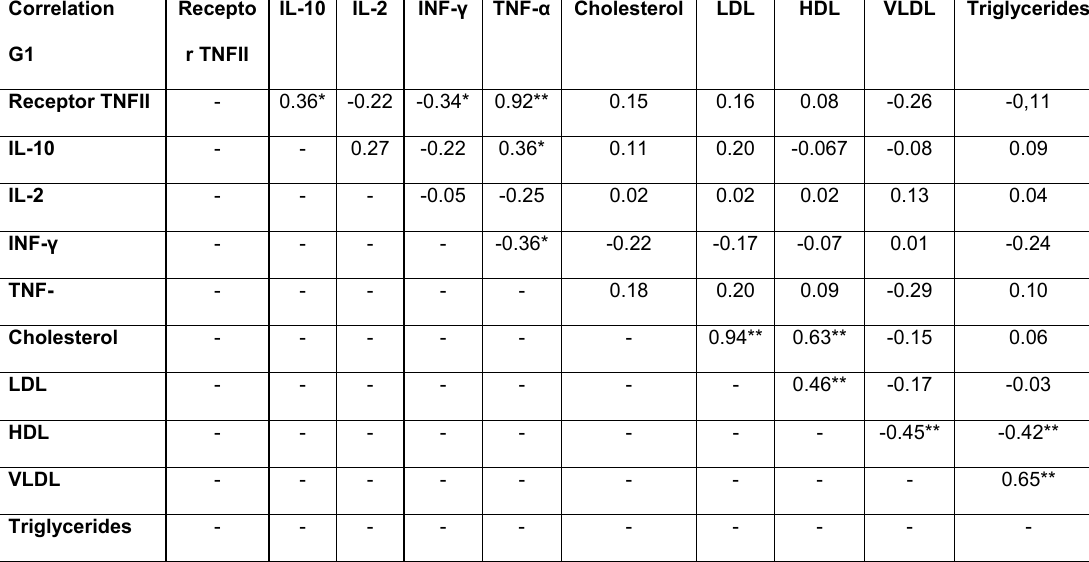
Table 5. Correlations between lipid profile and cytokines in G1 (with lipodystrophy).